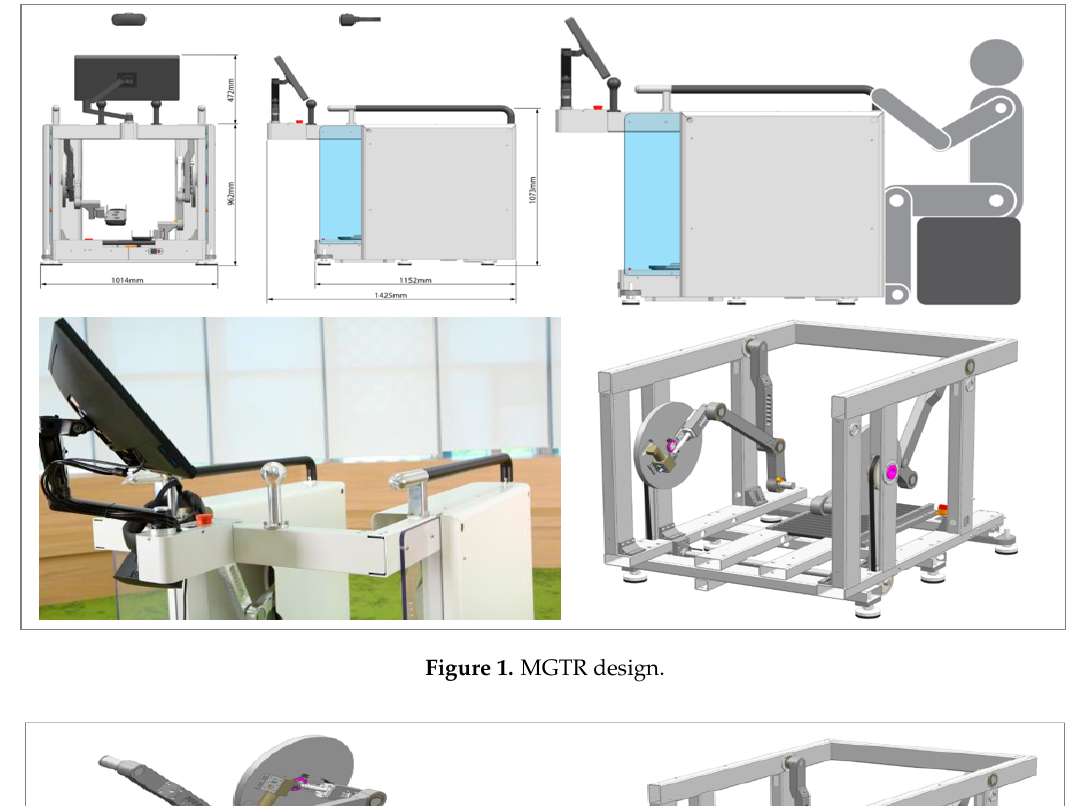
Figure 1. MGTR design.